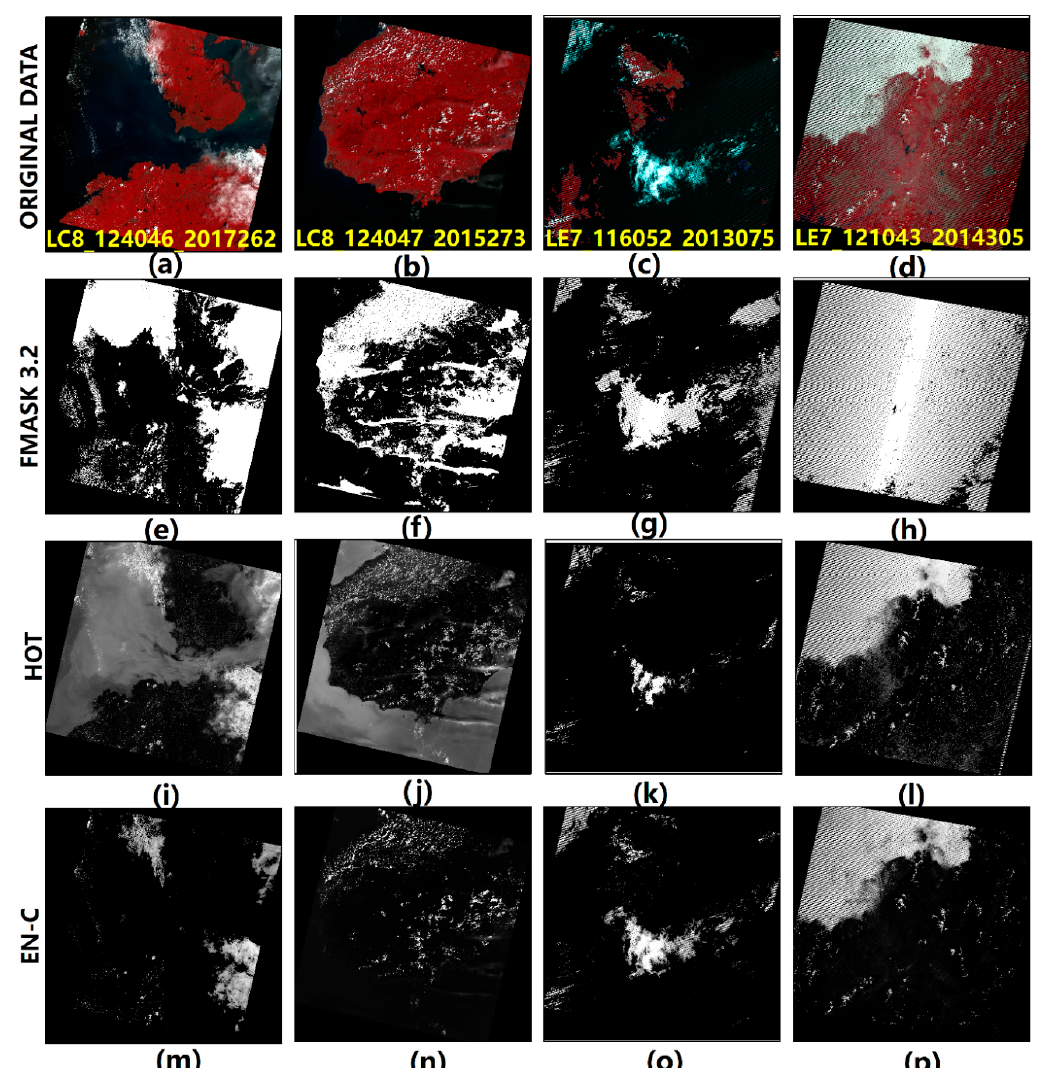
Figure 7. A qualitative comparison of the EN-Clustering algorithm for automatic cloud detection with the other commonly-used cloud detection algorithms. The upper row ( a – d ) presents the original data, i.e., the false-color composite images with bands 5, 4, and 3 of Landsat 8, and bands 4, 3, and 2 of Landsat 7, denoting the NIR, Red, and Green bands, respectively. The second row ( e – h ) presents the cloud detection results generated using the F-mask algorithm. The third and fourth rows present the cloud detection results of HOT ( i – l ) and the EN-Clustering ( m – p ) algorithm, respectively. The white region represents the cloudy region, while the black region represents the cloud-free region.